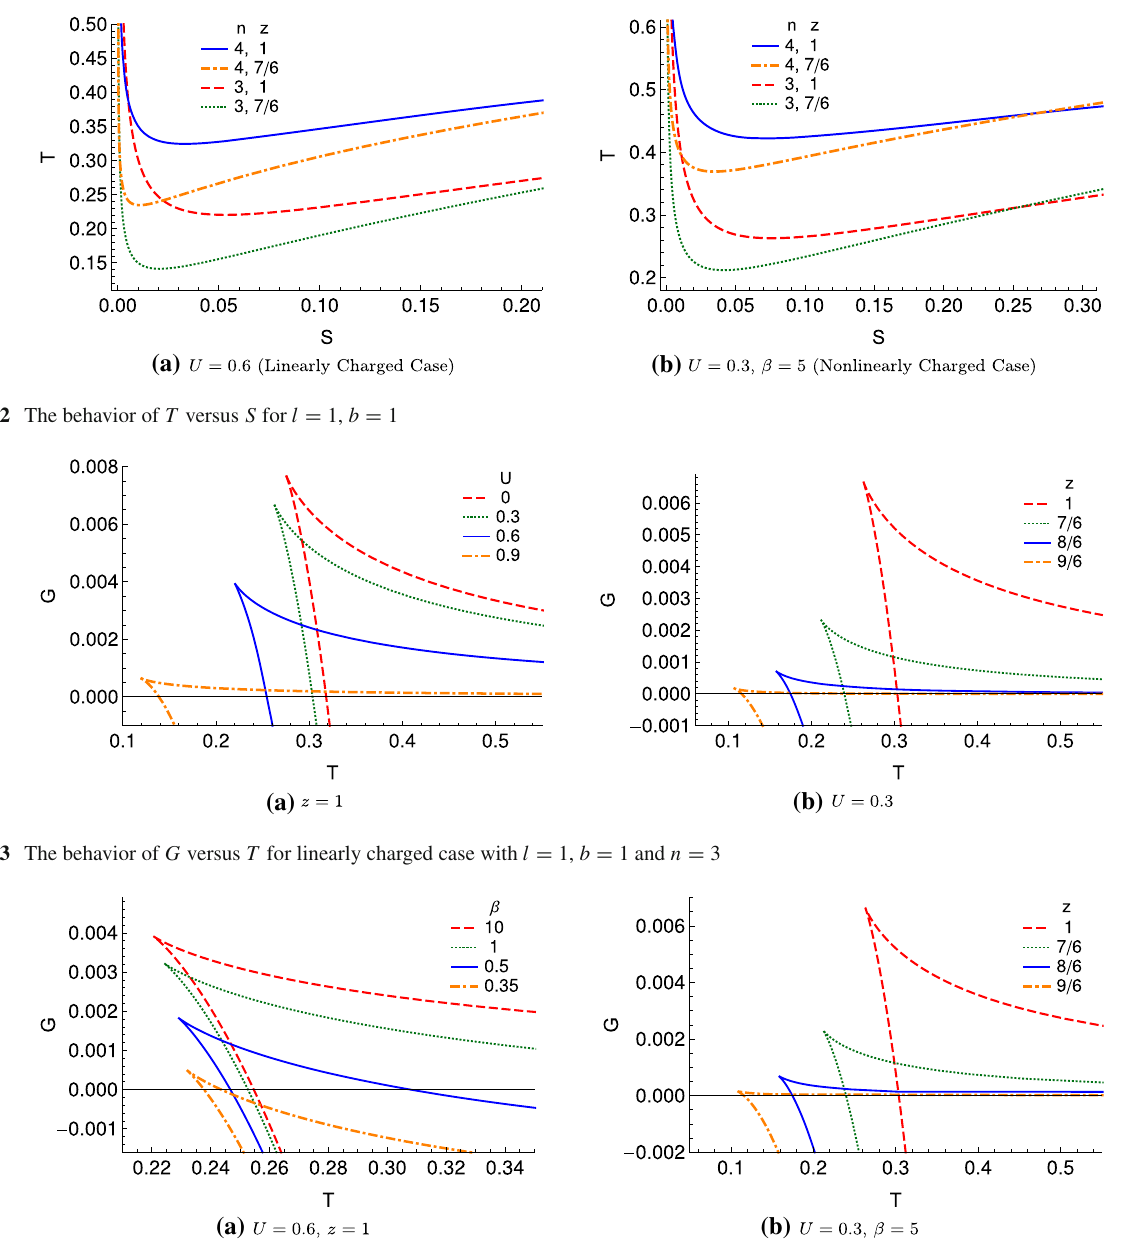
Fig. 4 The behavior of G versus T for nonlinearly charged case with l = 1, b = 1 and n =